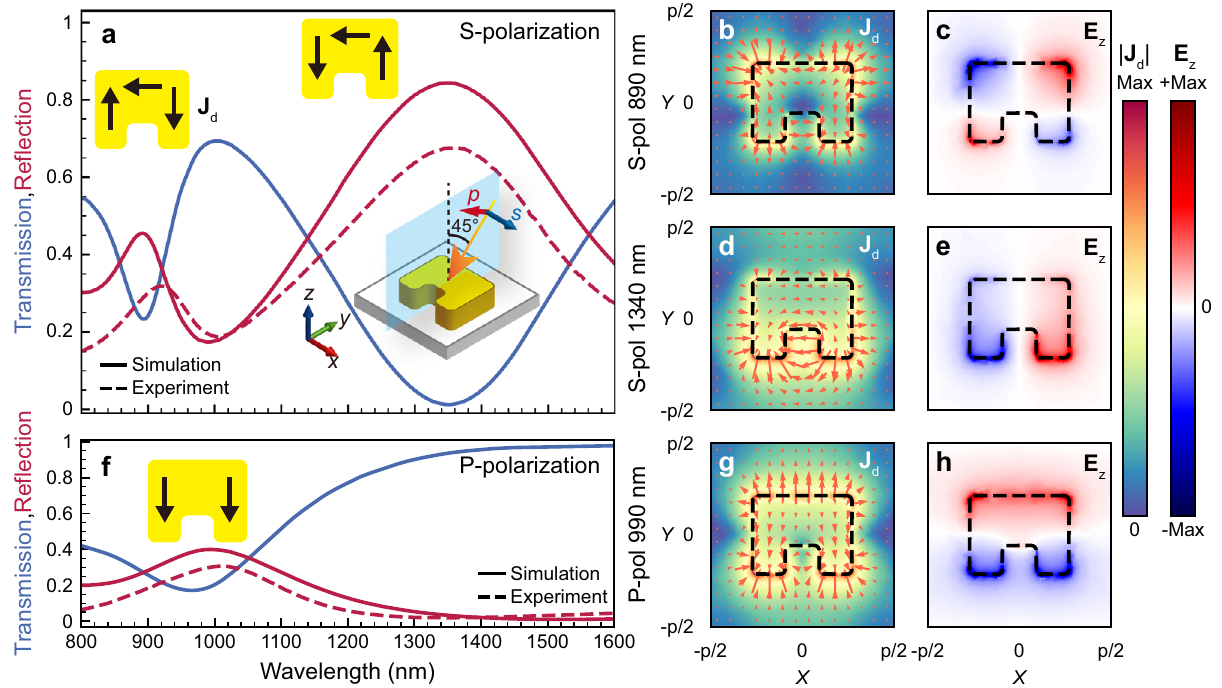
Fig. 2 Transmission, re fl ection spectra and mode pro fi les of the SRRs. a Transmission and re fl ection spectra under s-polarized incidence with an incident angle of 45° (dashed line is the measured re fl ection spectra). The inset shows the volume average of displacement currents J d distribution in the three arms of the SRR at resonance wavelengths of 890 and 1340 nm. b Displacement current and c E z fi eld distribution under s-polarized incidence at 890 nm wavelength. d Displacement current and e E z fi eld distribution under s-polarized incidence at 1340 nm wavelength. f Transmission and re fl ection